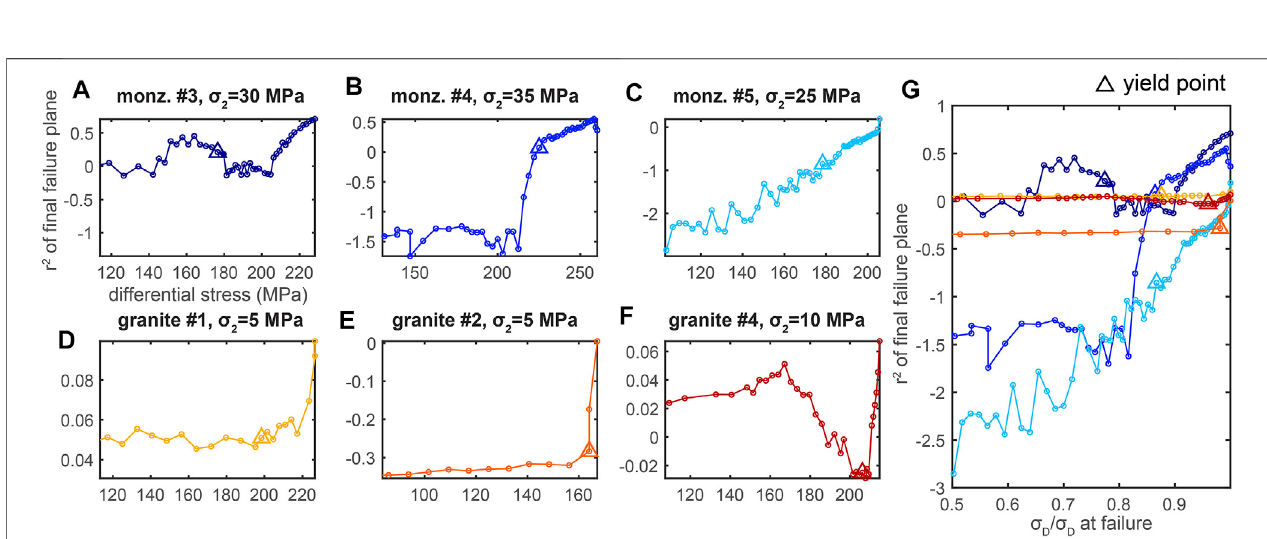
FIGURE9| Evolutionofthe r 2 ofthelargestfracturesandthe fi nalfailureplanethroughouteachindividualexperiment (A – F) ,andforalltheexperiments (G) .Colorof the lines in (G) matches the colors of each experiment shown in (A – F) . Triangles show the conditions of the yield point.